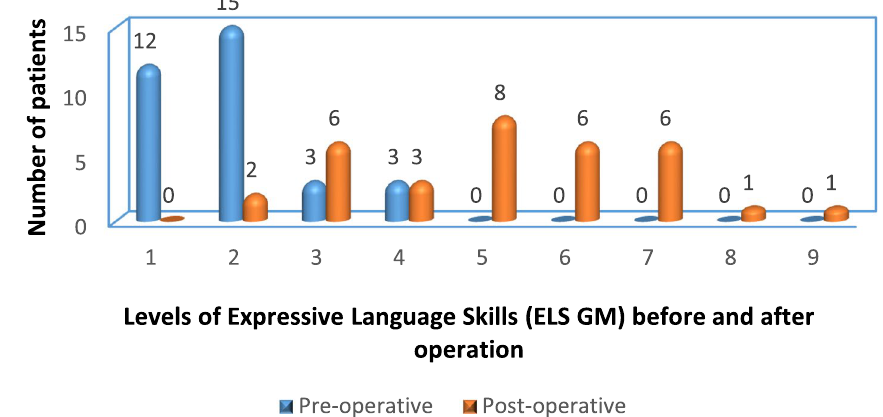
Fig. 2 Comparison between Levels of Expressive Language Skills (ELS GM) before and after operation